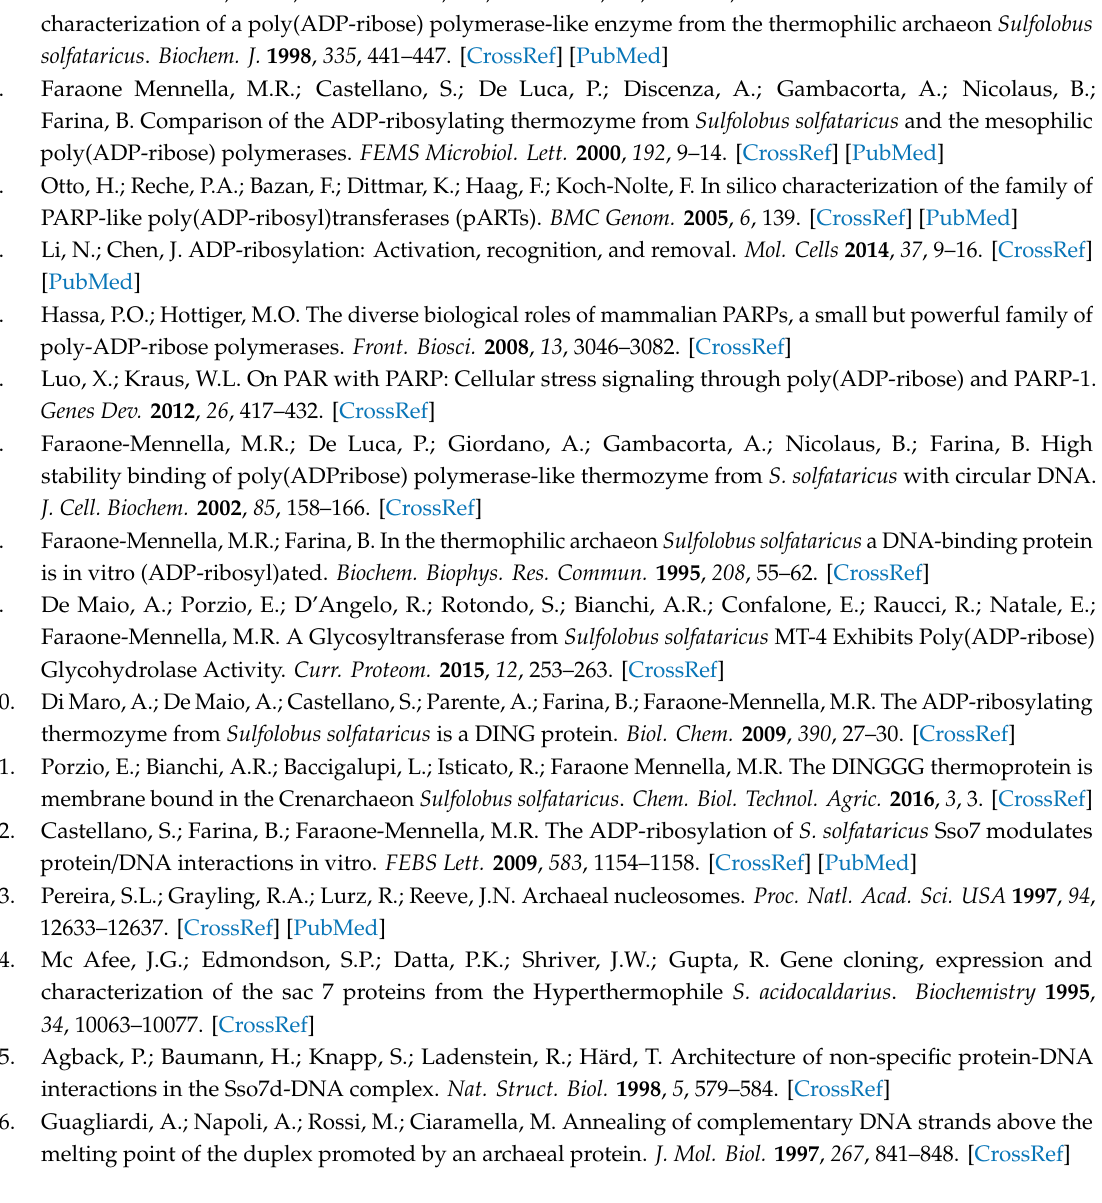
Figure S1: PARPSso Activity; Figure S2: Linearized plots of ADP-ribosylating activity in the presence of ATP; Figure S3: ATPase activity of PARPSso; Figure S4: Linearized plots of ATPase activity in the presence of NAD +